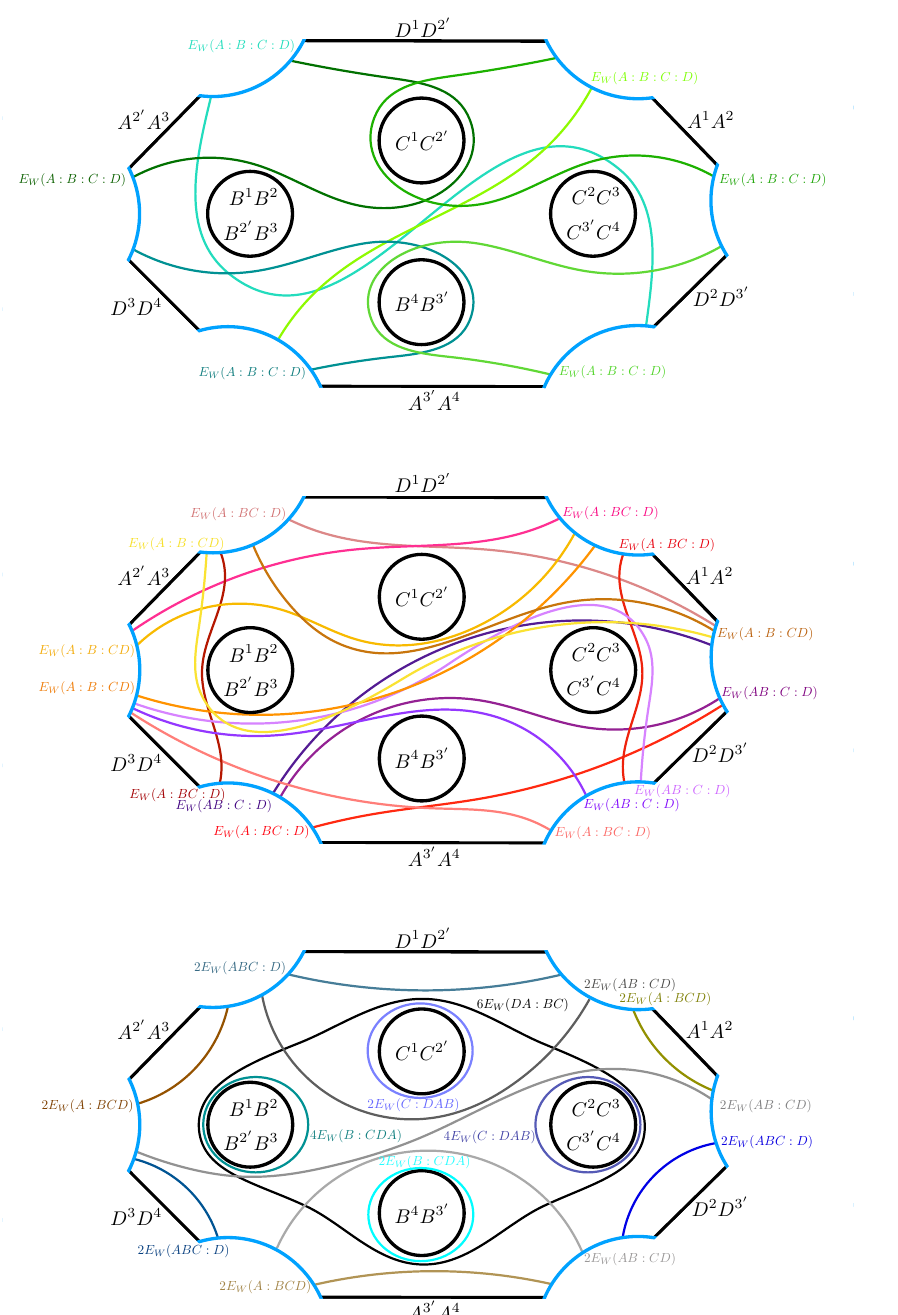
Figure 5 . ( A, D ) -anchored geodesics on M 0 that correspond to all E W surfaces achievable with our construction, with surfaces of different types shown as shades of different colors. The (inte- ger multiple of the) E W that each geodesic’s length computes is indicated. [Top] The four-party E W ( A : B : C : D ) surfaces. [Middle] Three-party surfaces. [Bottom] Two-party